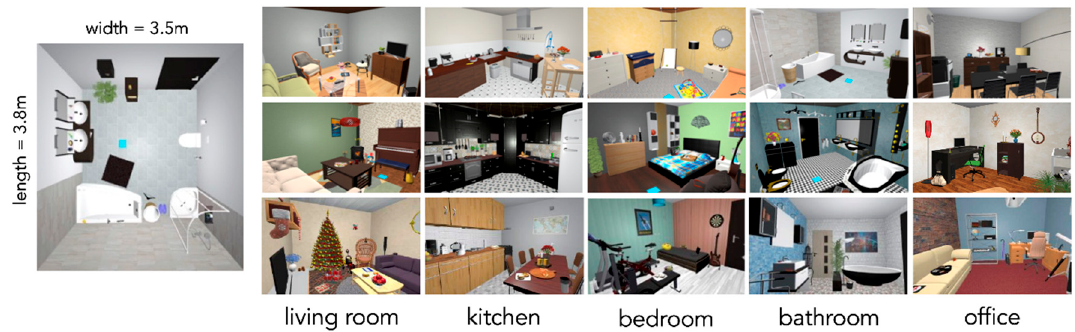
Figure 1. Bird’s-eye view of one of the bathrooms and one sample view of all the scenes that were used in the experiment. Blue squares indicate the starting position of the participants and were not visible during searching.